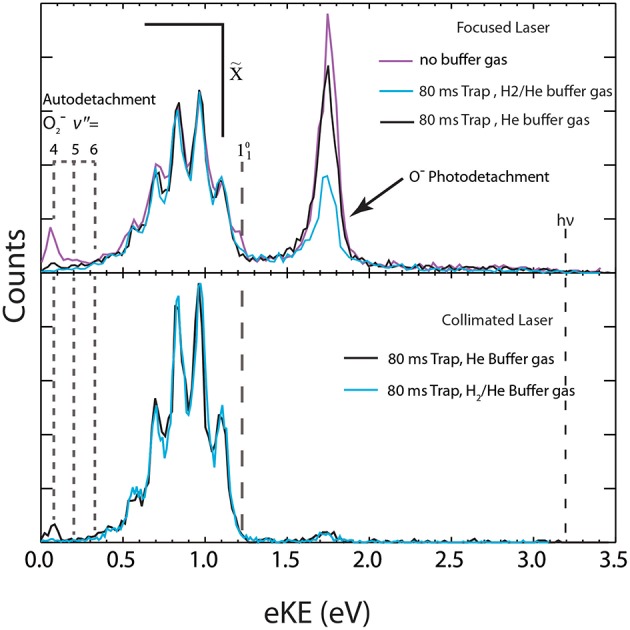
The total photoelectron spectrum for O3- with different buffer gas and laser configurations is shown. Top panel (high laser fluence): spectra collected without buffer gas (purple trace), with H2/He buffer gas (blue trace) and with neat He buffer gas (black trace). Bottom panel (low laser fluence): Both O3- spectra collected at 17 K with 80 ms trapping time with either neat He buffer gas (black trace) or H2/He buffer gas (blue trace).